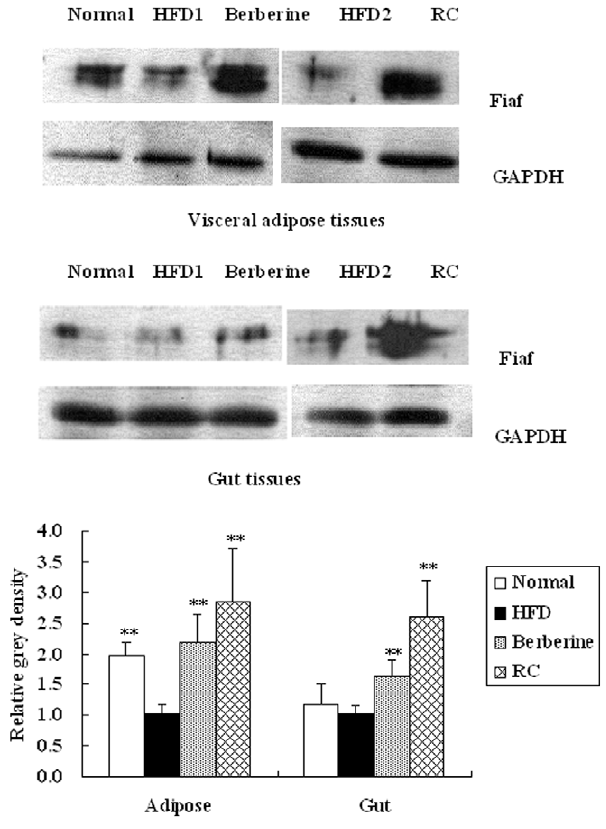
Figure 5. Effects of RC and berberine on Fiaf protein expressions in intestinal and adipocyte tissues. ‘‘Normal’’, normal chow diet-fed mice; ‘‘HFD’’, high-fat diet-fed control mice; ‘‘berberine’’, berberine-treated HFD mice; ‘‘RC’’, Rhizoma coptidis -treated HFD mice. Data were expressed as Mean 6 S.D. (n=6), * P , 0.05, ** P , 0.01 vs. HFD